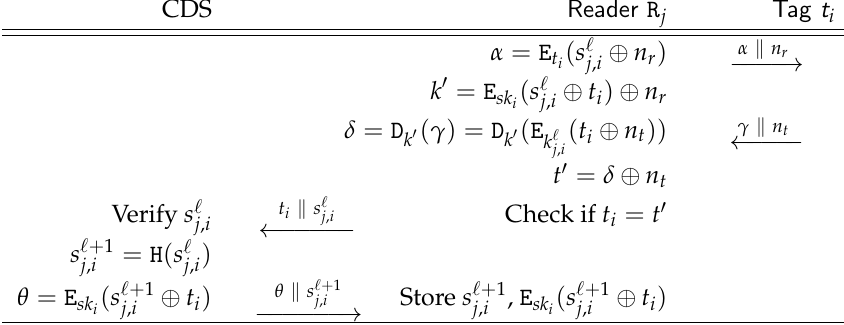
Figure 3. Access List Update